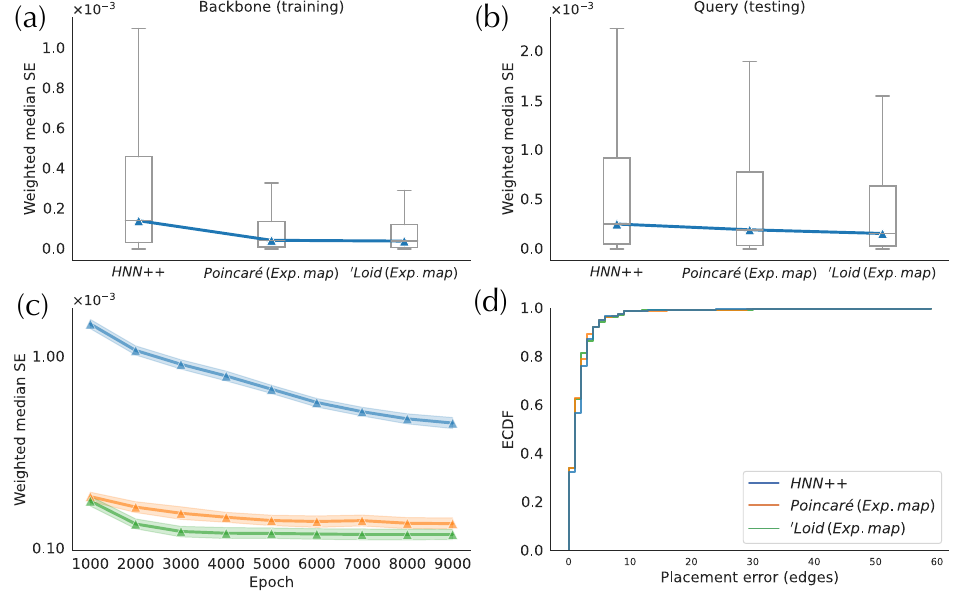
Figure 3. Comparison of different implementations of hyperbolic embeddings on WoL 16S data. ( a ) Mean square error (MSE) of embedding distances between backbone species. ( b ) MSE of em- bedding distances between query species and backbone species ( c ) Convergence of the models. ( d ) Empirical distribution function (ECDF) of the placement